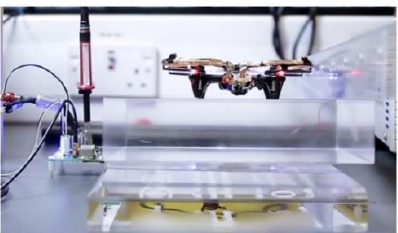
Figure 5. Wireless charging hovering drone. Reproduced with permission from Ref. [22]; published by IEEE, 2017.